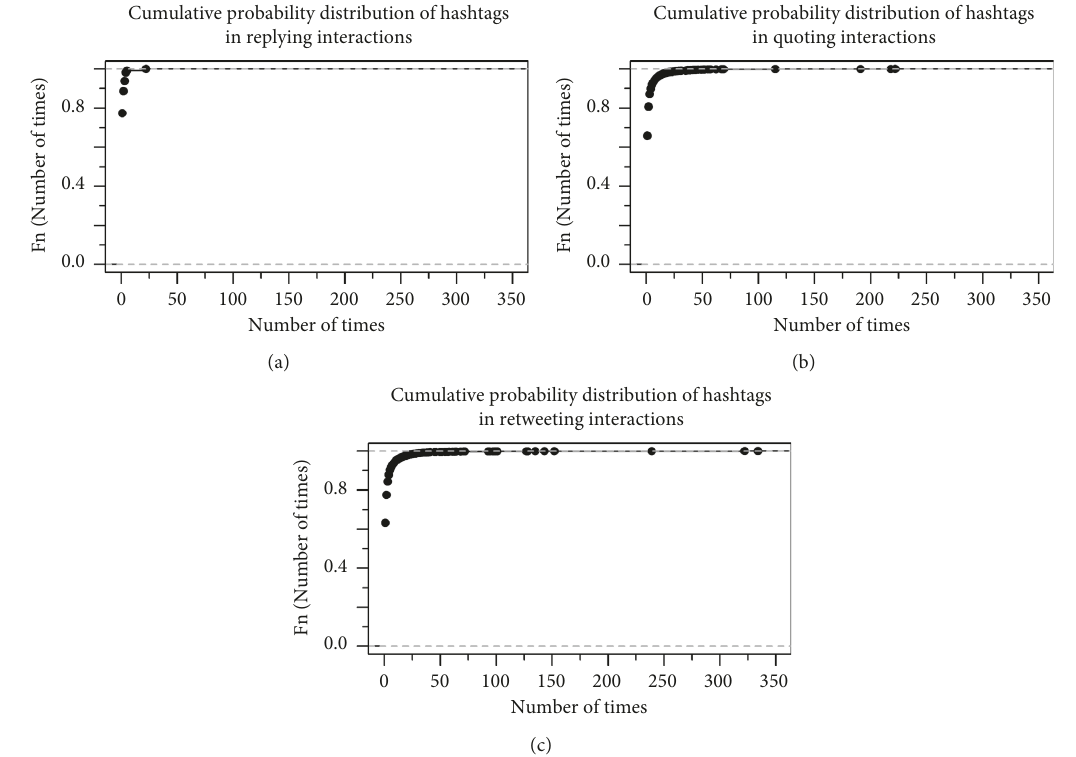
Cumulative probability distribution of hashtags in replying interactions